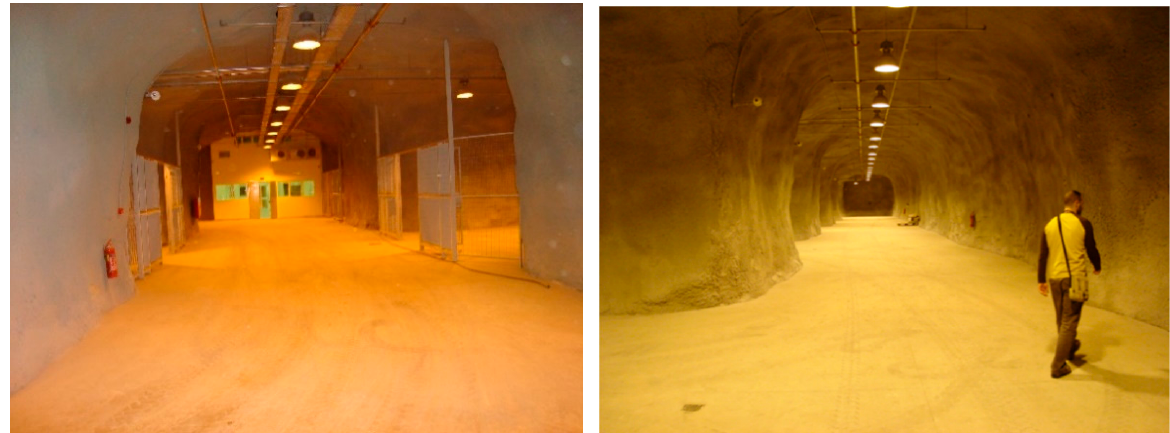
Figure 4. Perspective of UHWR underground space.